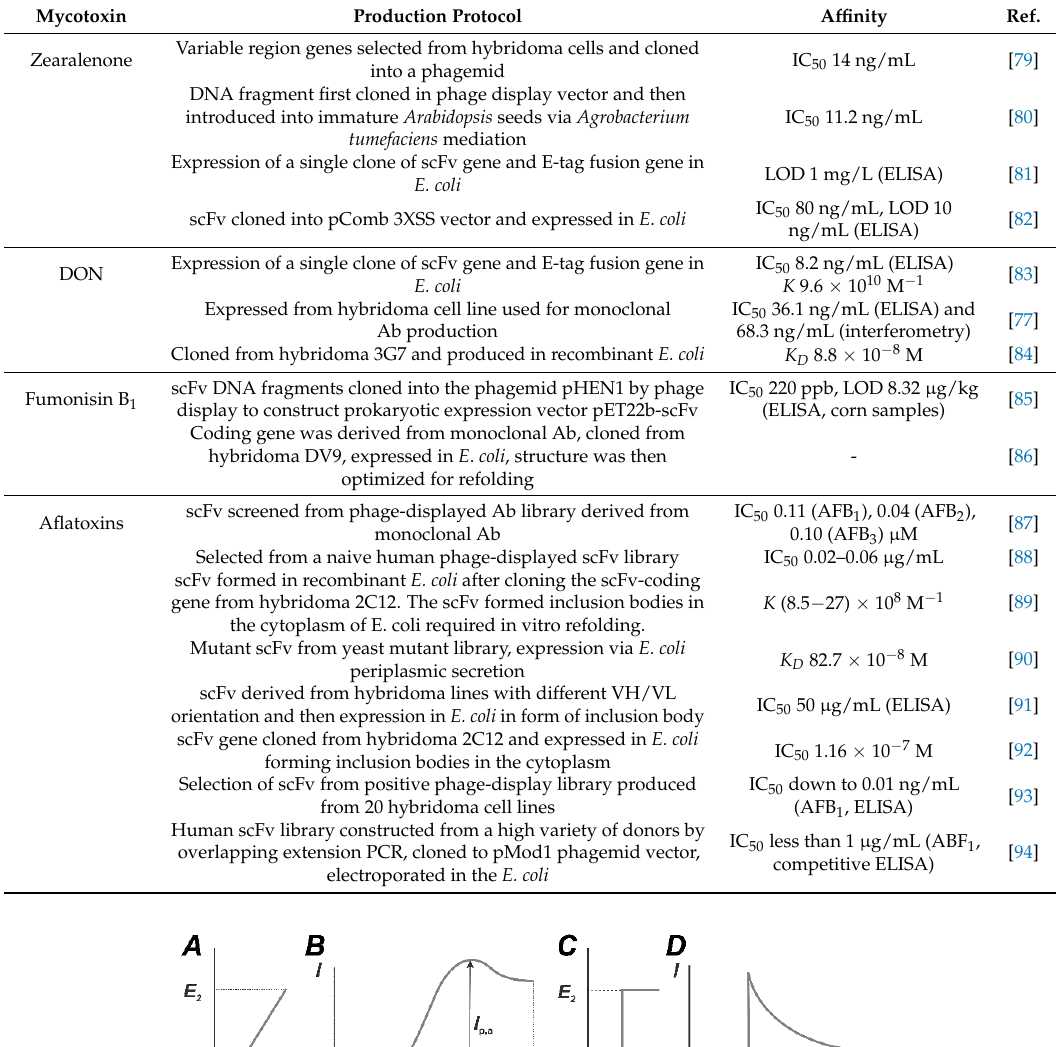
Table 1. Single-chain variable fragment (scFv) antibodies of Abs for mycotoxin determination (IC 50 – concentration corresponded to 50% change of the signal. ELISA – enzyme linked immune sorbent assay, K -affinity constant, K D -dissociation constant, LOD—limit of detection). Mycotoxin Production Protocol